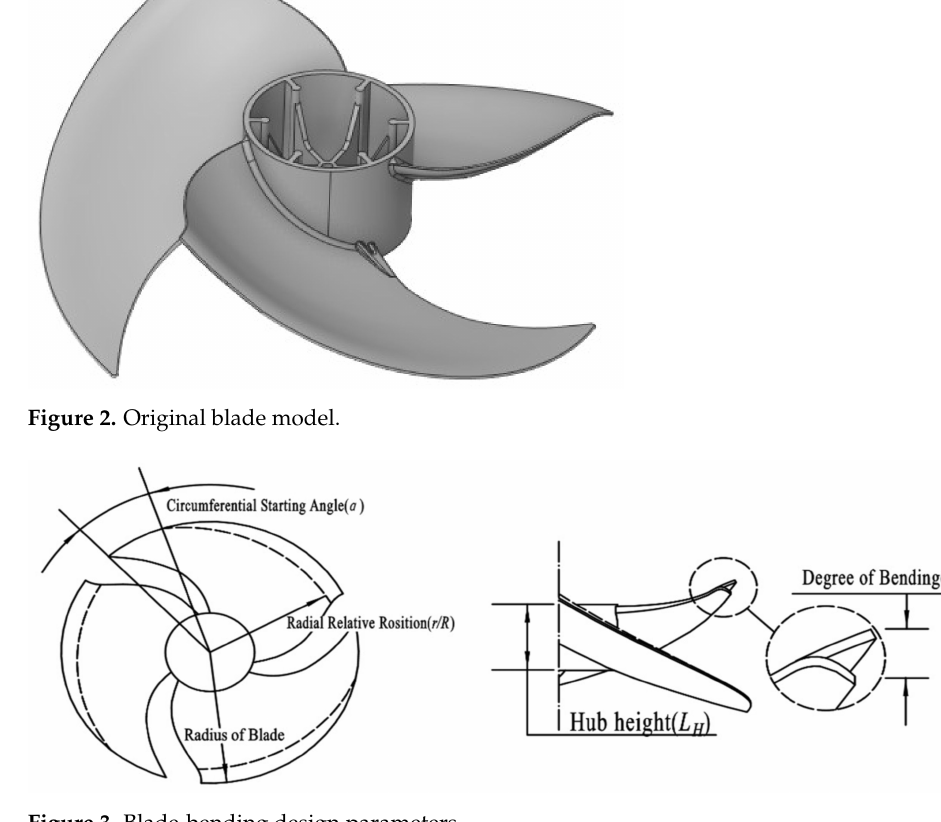
Figure 3. Blade-bending design